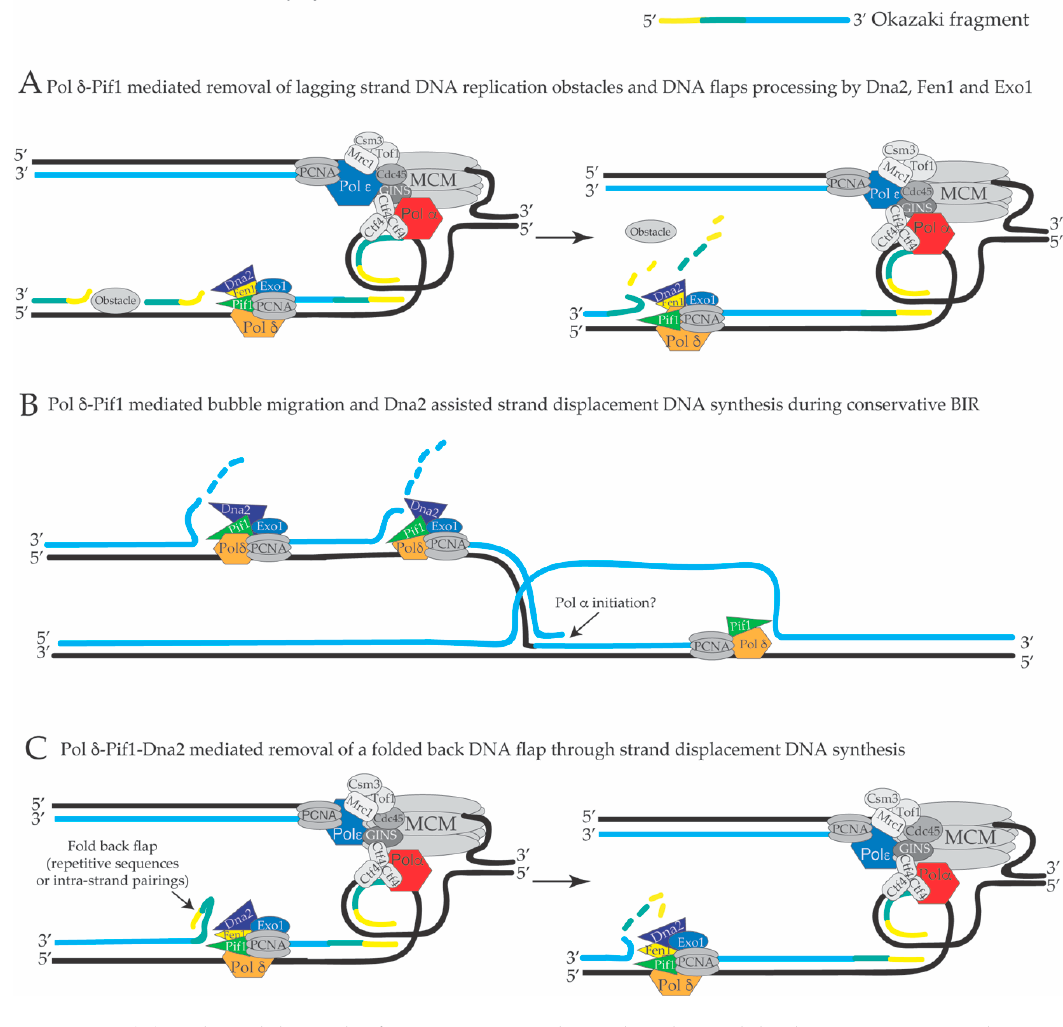
Figure 4. ( A ) Backward directed Pif1-PCNA-Dna2-Pol δ mediated strand displacement DNA synthesis and flap cutting may be utilized to remove DNA replication obstacles such as non-nucleosomal DNA-protein complexes and R-loops created by the transcription units to counteract DNA replication fork pausing (see the text). ( B ) Pif1-Pol δ mediated D-loop bubble migration and extended strand displacement DNA synthesis coupled to Dna2-dependent cutting of the resulting DNA flaps during conservative BIR (break-induced replication) contribute to create a fully replicated duplex. ( C ) Backward directed Pif1-PCNA-Dna2-Pol δ -mediated strand displacement DNA synthesis and